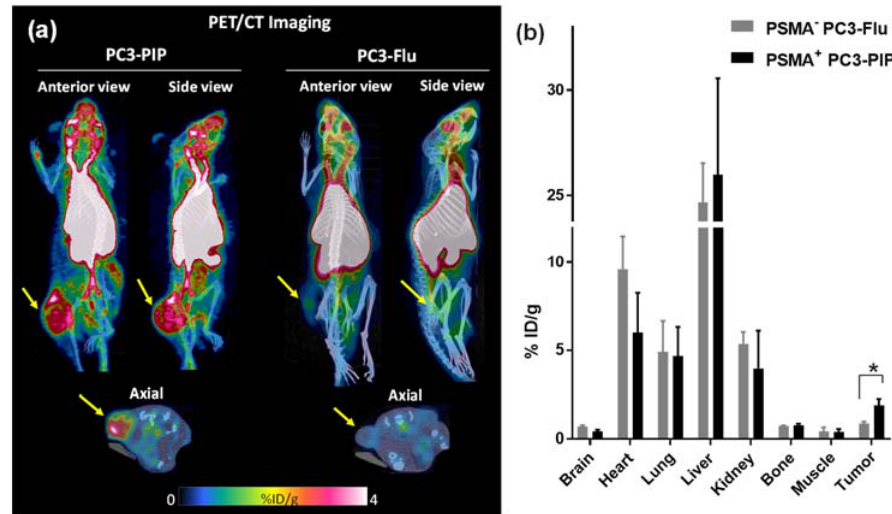
Figure 4. ( a ) Representative PET/CT images of SCID mice bearing PSMA + PC3-PIP and PSMA − PC3- Flu xenografts at 1 h p.i. of [ 18 F]F-TZ(PSMA)-LEGU-TLR7. Yellow arrows indicate the tumor location. ( b ) Quantitative analysis of tissues of interest. Data presented as average %ID/g ± s.d. ( n = 3). * p = 0.02 (unpaired t-tests performed by GraphPad Prizm 7.04).